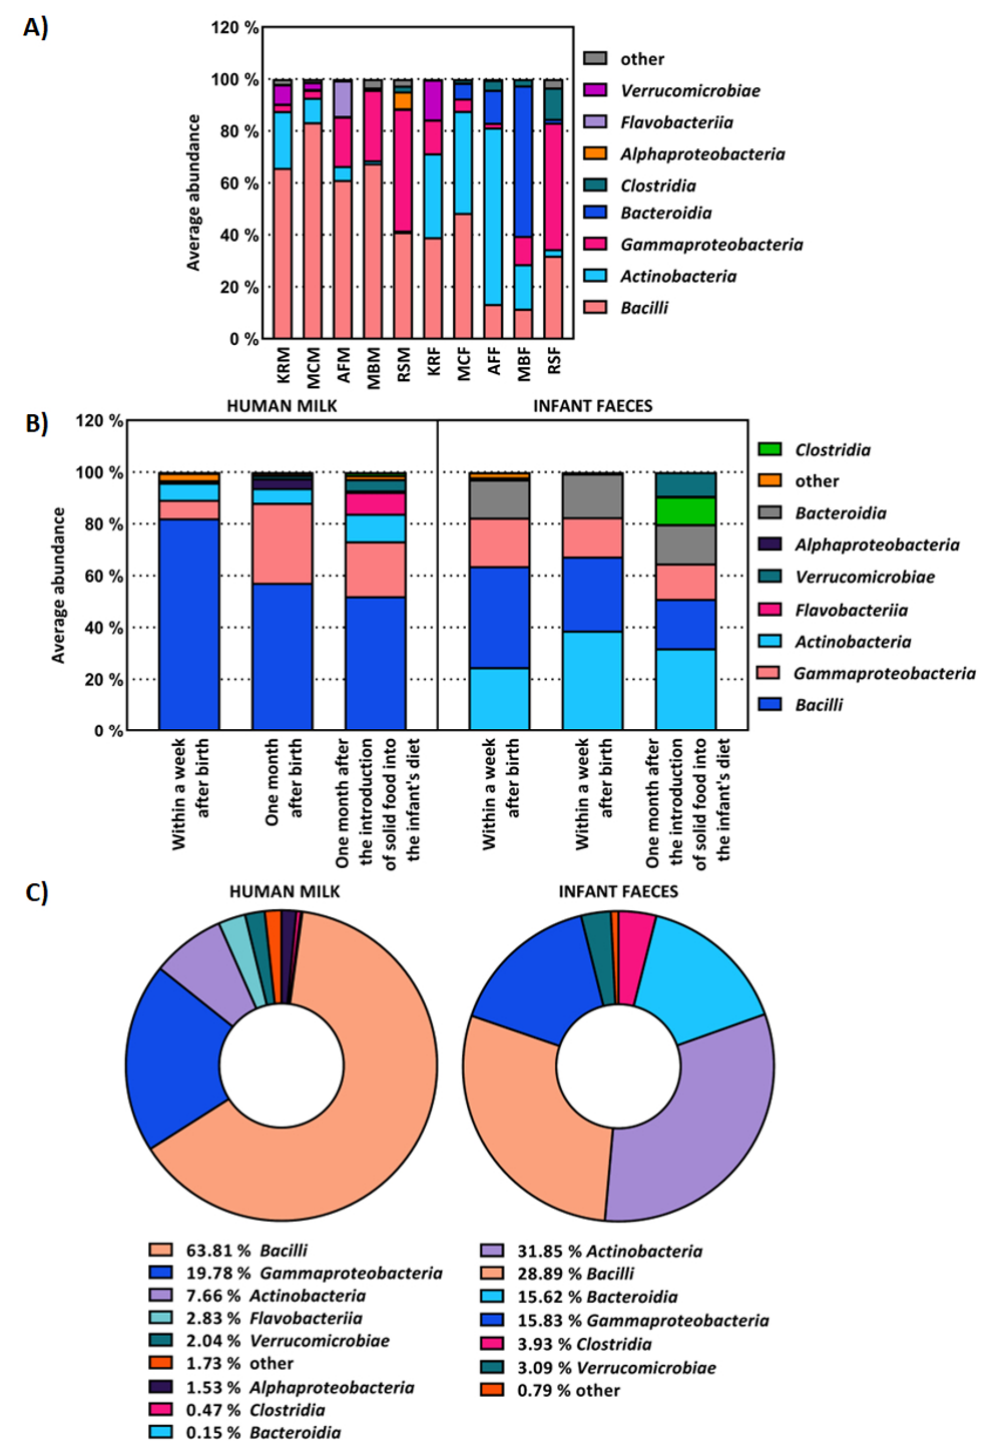
Figure 2. Average abundance of OTUs at class level of: ( A ) human milk samples from the same mother (M), i.e., faeces (F) from the same infant, ( B ) all human milk and infant faeces samples collected within one week and one month after birth, and one month after the introduction of solid food into the infant’s diet, ( C ) all human milk and infant faeces samples. OTUs with an average representation of less than 2% are classified as